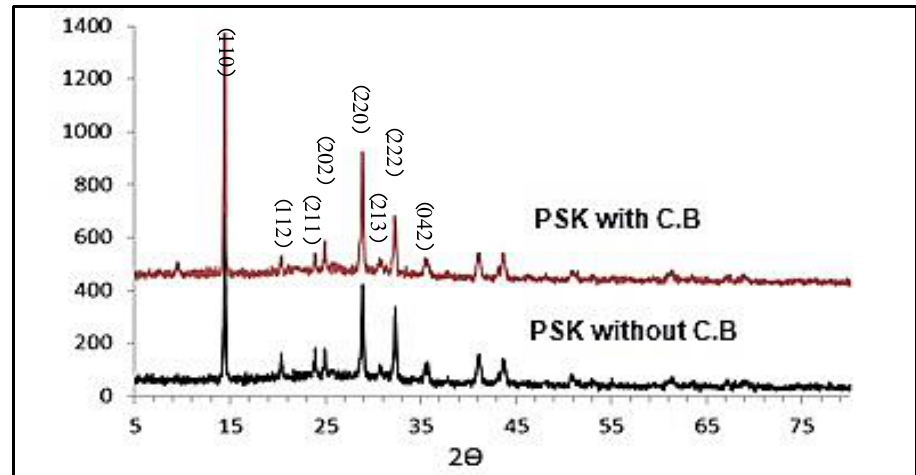
Figure 3: X-ray diffraction pattern of the PSK layer with and without using chlorobenzene as anti-solving.